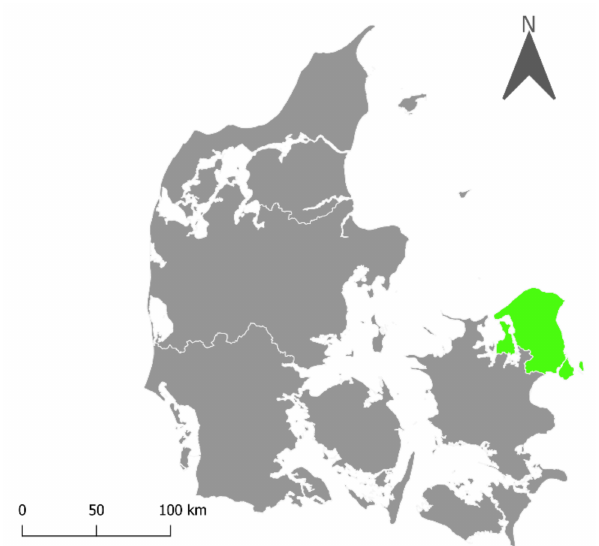
Figure 1. Map of Denmark with the selected study area, Hovedstaden, marked in